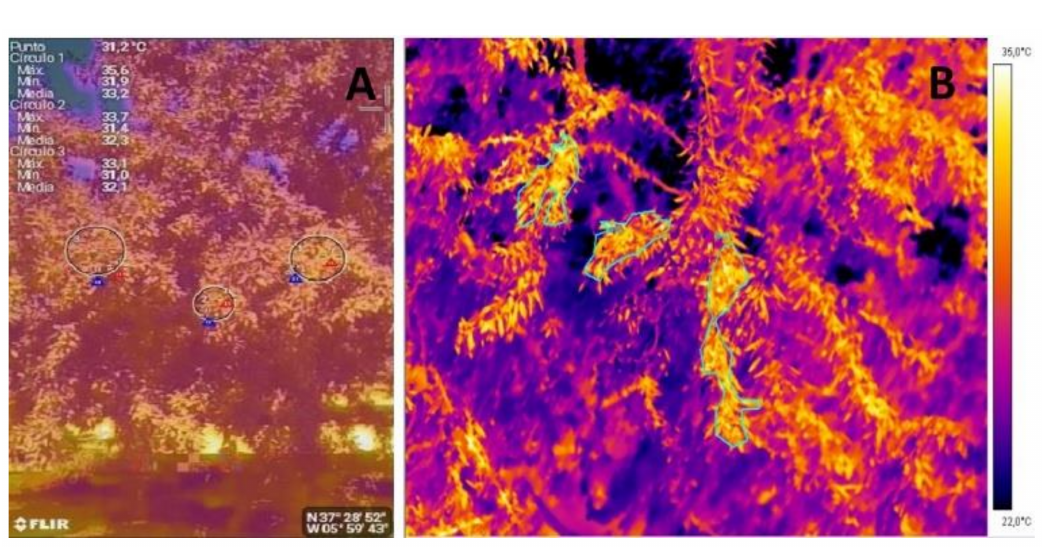
Figure 2. False colored images taken by using ThermaCam (Flir One, Flir Systems, USA) connected to